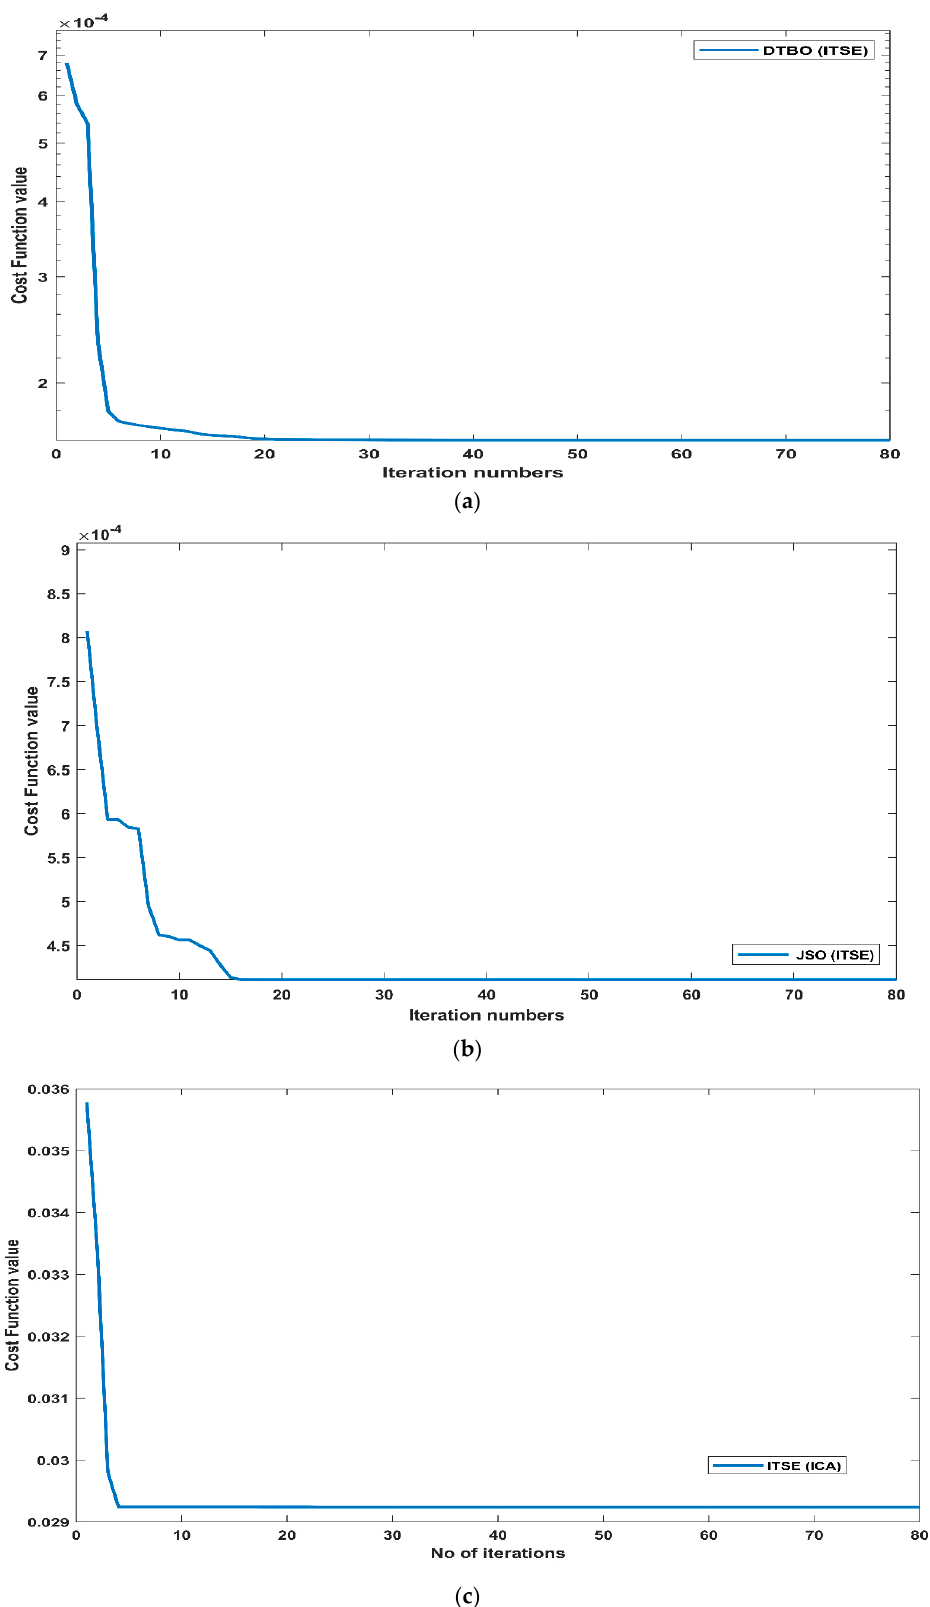
Figure 10. Convergence characteristics curve for algorithms ( a ) DTBO ( b ) JSO ( c )